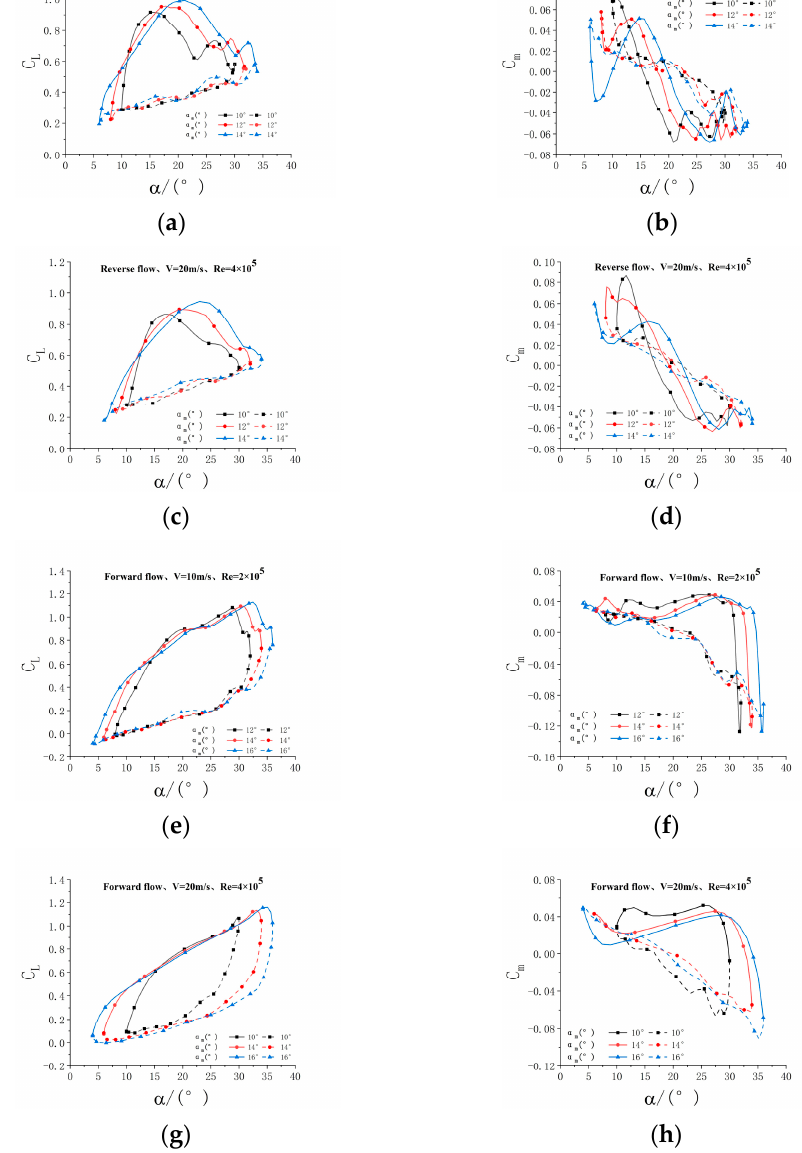
Figure 17. Effect of the oscillation amplitude at different Reynolds numbers. ( a ) Re = 2 × 10 5 , C L , ( b ) Re = 2 × 10 5 , C m , ( c ) Re = 4 × 10 5 , C L , ( d ) Re = 4 × 10 5 , C m , ( e ) Re = 2 × 10 5 , C L , ( f ) Re = 2 × 10 5 , C m , ( g ) Re = 4 × 10 5 , C L , ( h ) Re = 4 × 10 5 , C m .